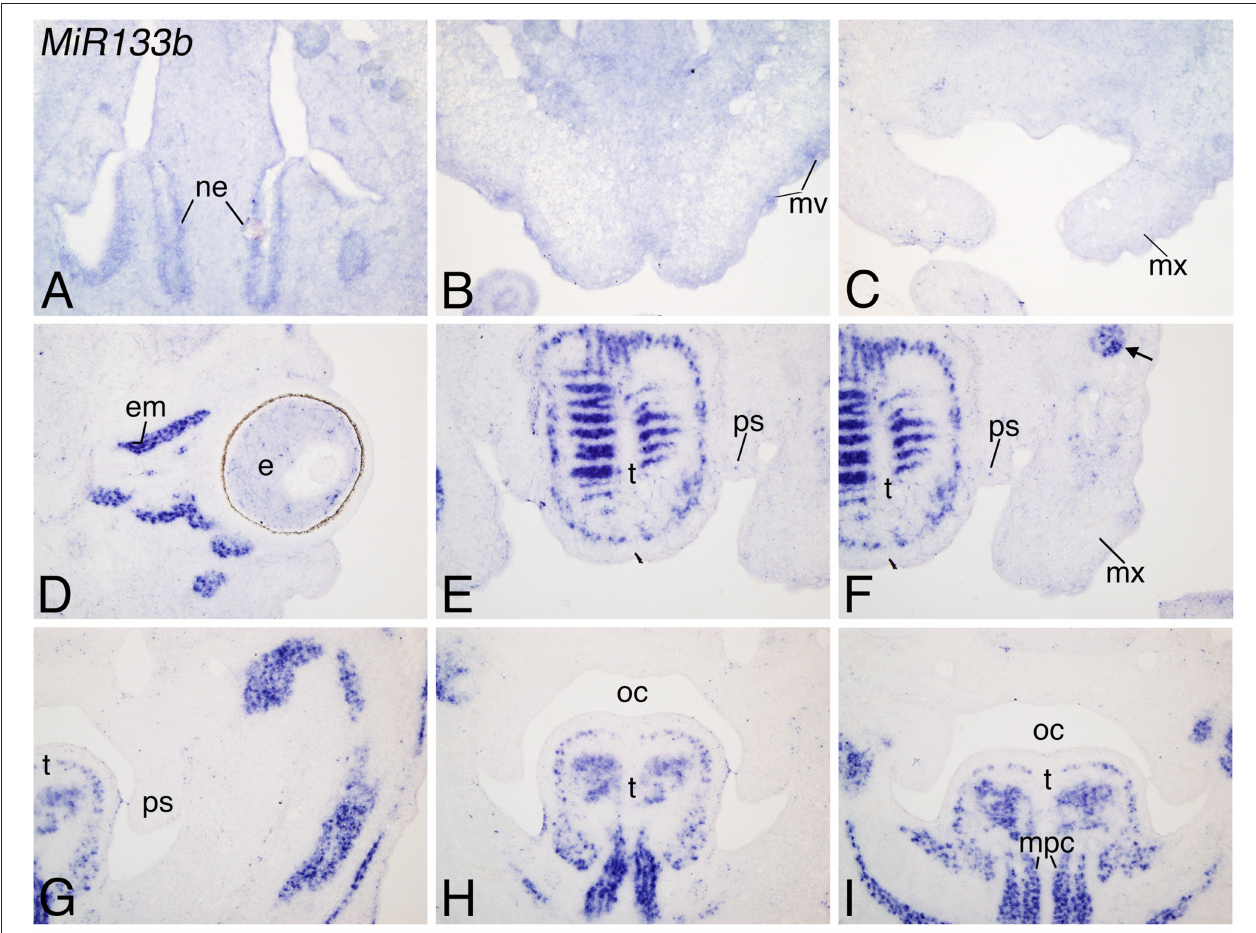
FIGURE 4 | Expression of Mir133b in mouse facial muscles at E12.5. ISH analysis in frozen frontal sections through the head of E12.5 mouse embryos. (A–C) Mir133b is weakly expressed in the nasal epithelium (ne; A ), mystacial vibrissae (mv; B ), and maxilla (mx); (D–F). (mx); (D–F). Mir133b is strongly expressed in facial muscles, including the masseter (ma), and in the muscles of the eye (em; D ) and tongue muscle (t; E–I ) Expression is not observed in the palatal shelves (ps; E,F ). (G–I) Posterior expression continues continues in the tongue muscles. e, eye; oc, oral